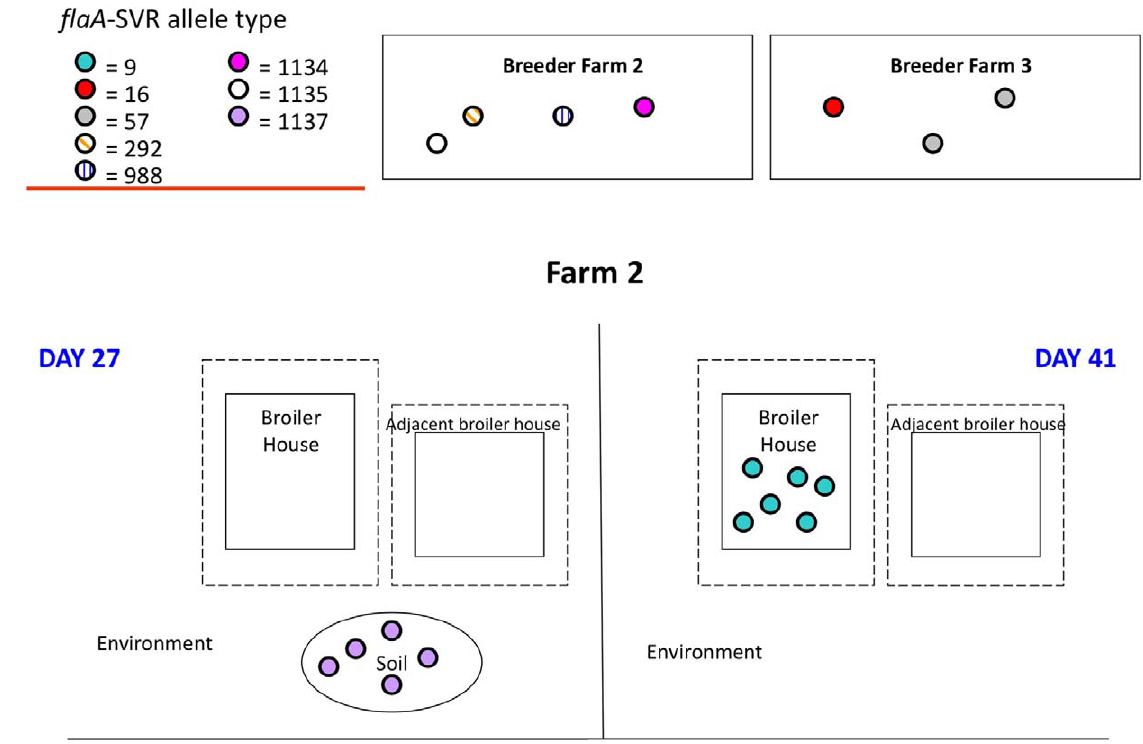
Figure 3. Schematic diagram of the flaA -SVR alleles detected on farm 2.